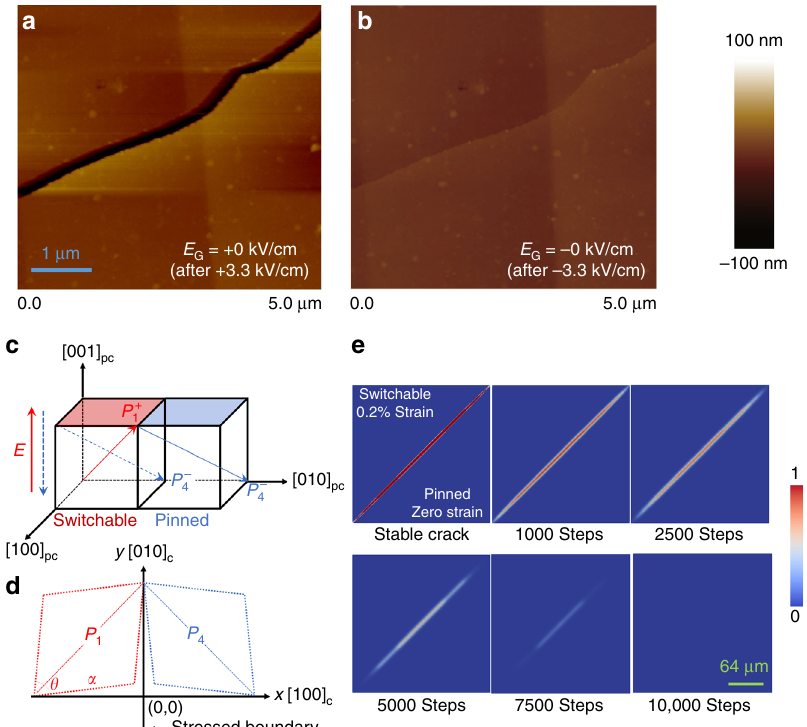
Fig. 3 Reversible crack driven by an electric fi eld. Atomic force microscopy images (5 × 5 μ m 2 ) of a single crack in the MnPt fi lm after scanning the gate electric fi eld E G a from +3.3 kV/cm to 0 kV/cm and b from − 3.3 kV/cm to 0 kV/cm. c , d Schematics showing that electric- fi eld ( E )-induced reversible and nonvolatile crack formation and closure on the (001) PMN-PT surface can result from a reversible and nonvolatile E -induced 109° polarization switching. A two-domain con fi guration consisting of one switchable polarization domain and one pinned domain is considered. Such reversible 109° polarization switching can repeatedly induce an in-plane shear strain of about 0.2% in the switchable domain, which will repeatedly stress the domain boundary. The 0.2% strain is calculated based on the lattice parameters ( a , θ ) of the rhombohedral (001) PMN-PT. e Phase- fi eld simulations of the crack evolution when the strain is ON (the fi rst image in the fi rst row) and OFF (the remaining images). Color bar shows the magnitude of the phase variable, which equals 1 in the crack region and 0 in the PMN-PT, and changes continuously across their